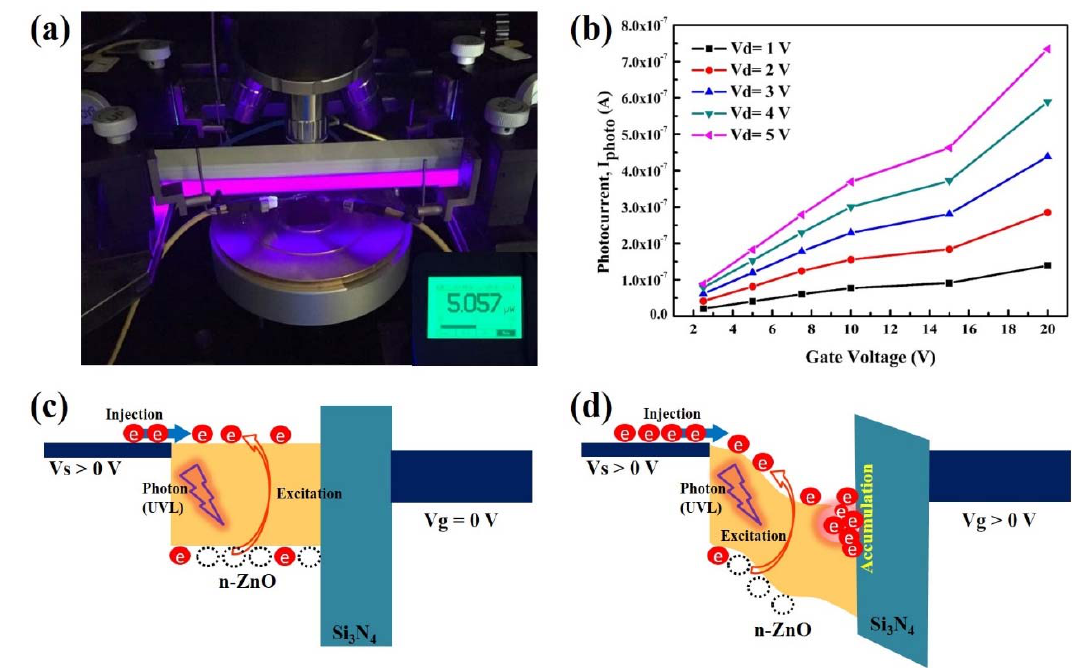
Figure 5. ( a ) Photograph of the ZnO-based photodetector on a semiconductor measuring the load under UV illumination. ( b ) Photocurrent increase associated with the gate bias and drain bias increase. The gate bias influenced the ZnO energy band bending of the photodetector and amplification mechanism. ( c ) Photocurrent induced by UV light without gate bias and ( d ) with gate bias voltage.